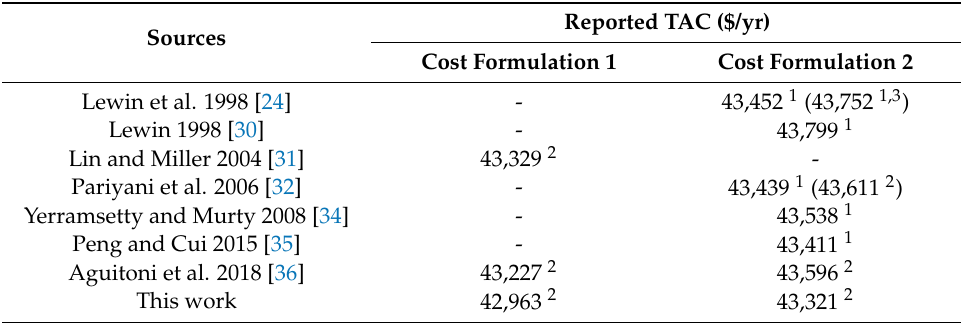
Table 2. Results comparison for example 1a.